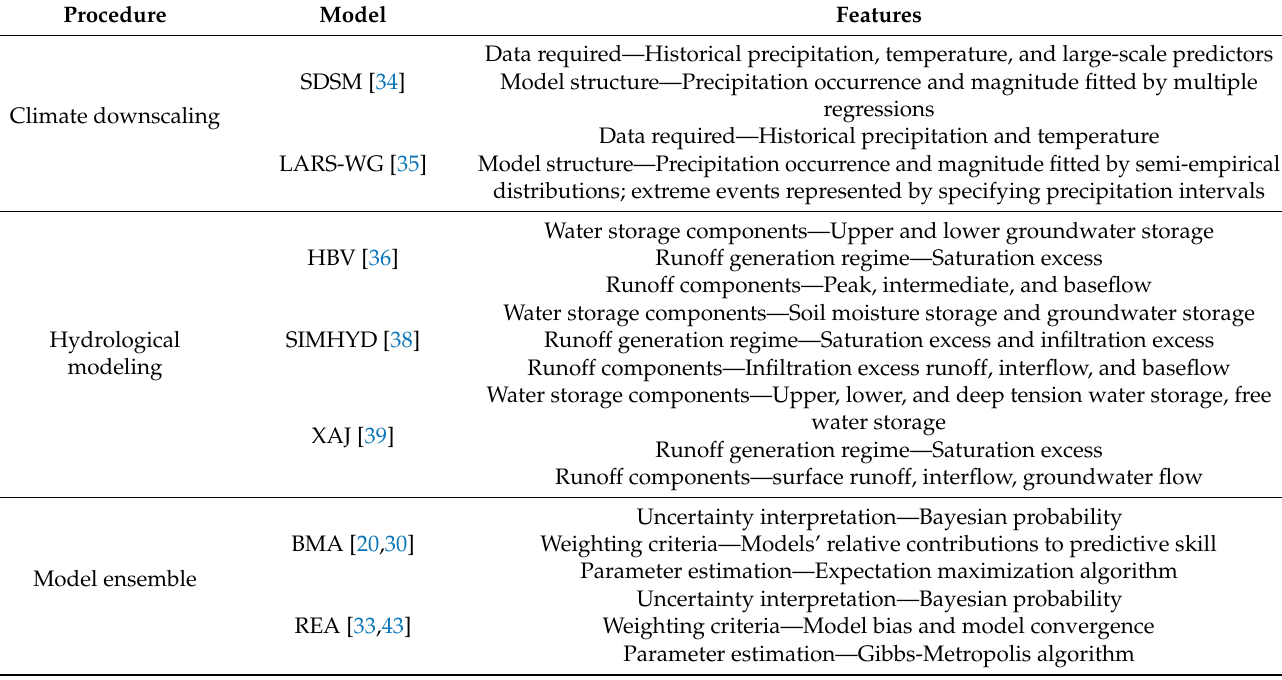
Table 1. Comparison of the methods used in this